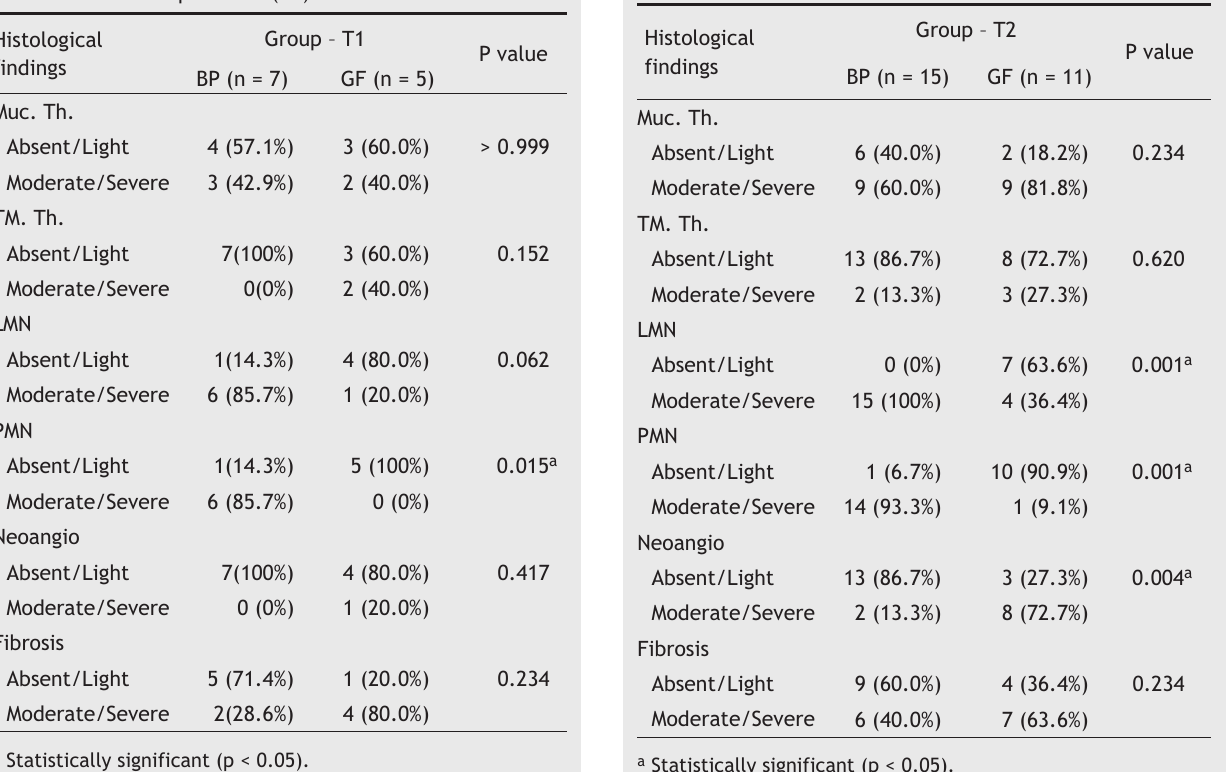
Table 4 Comparison between groups of biomaterials in relation to histological findings in the tympanic bulla of rats after 3 months of experiment